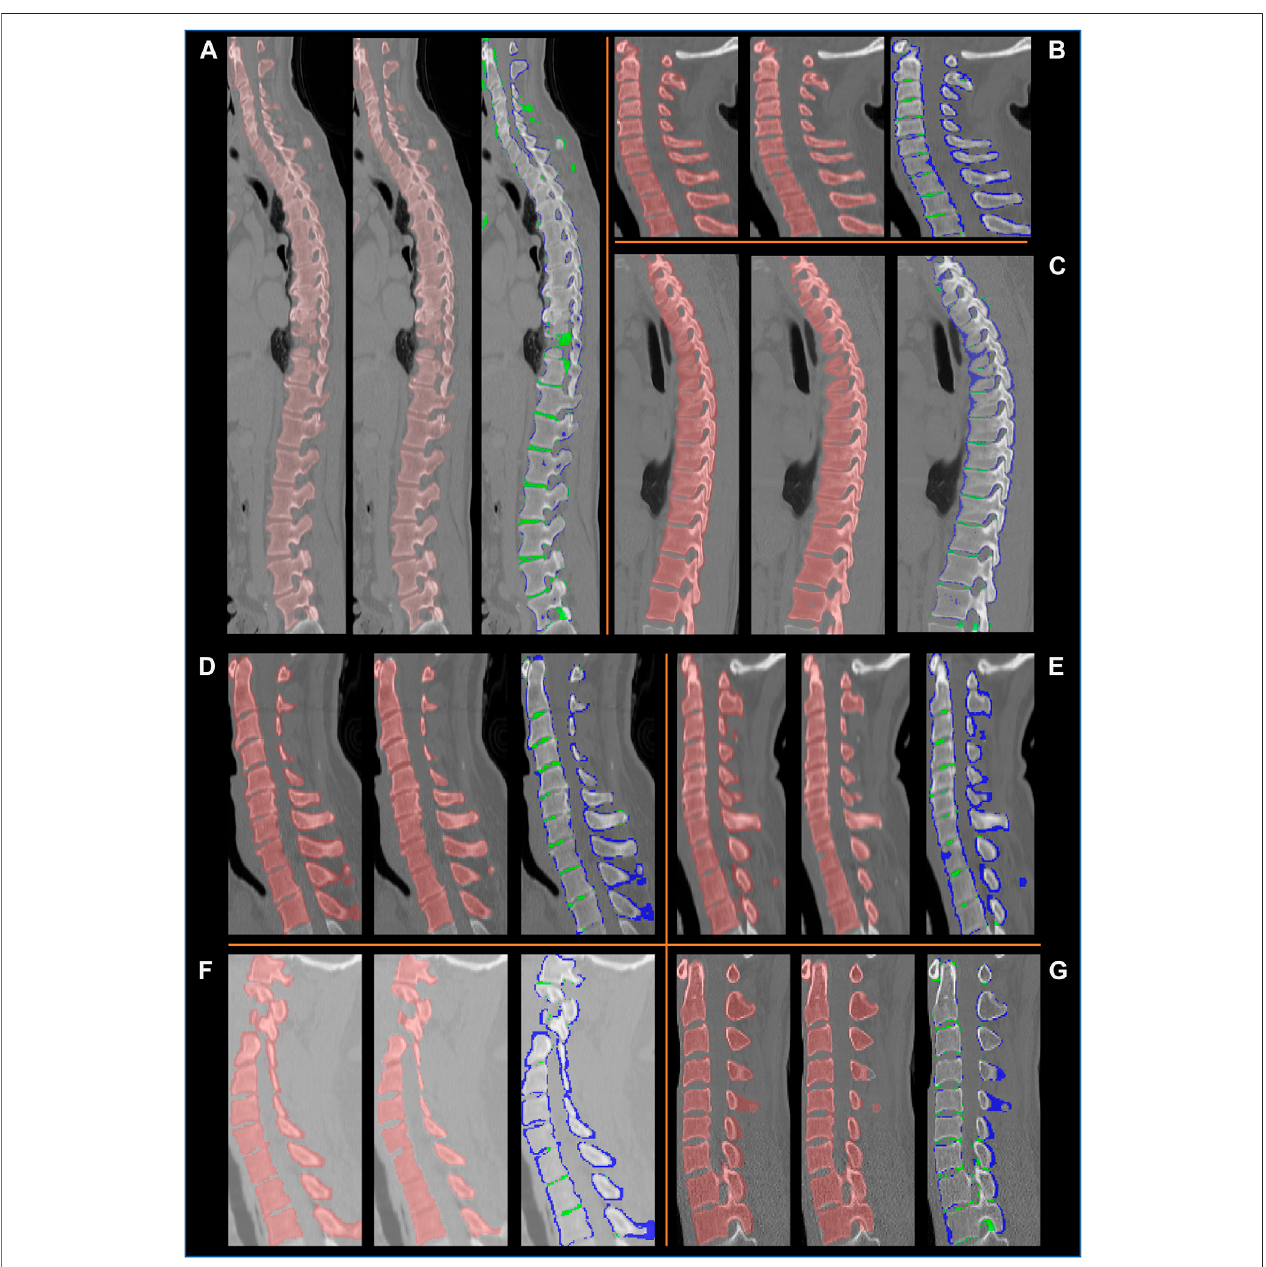
FIGURE 9 | Example segmentation results on the VerSedatabase, shown in the sagittal plane for eightsubjects (A – G) . Foreach subject, a set ofthree images are presented: left :thegroundtruthlabels; middle :thesegmentationbyourmethod, right :thedifferencebetweenoursegmentation andthegroundtruthlabels. Inthelatter thevoxelsin blue areinthegroundtruthlabelsbutnotinoursegmentation, andthevoxelsin green aresegmentedbyourmethodbutarenotpresentinthegroundtruth labels. We observe that the ground truth labels ( blue ) can be outside the vertebral boundaries. Our method correctly delineates the vertebrae, except at some intervertebral